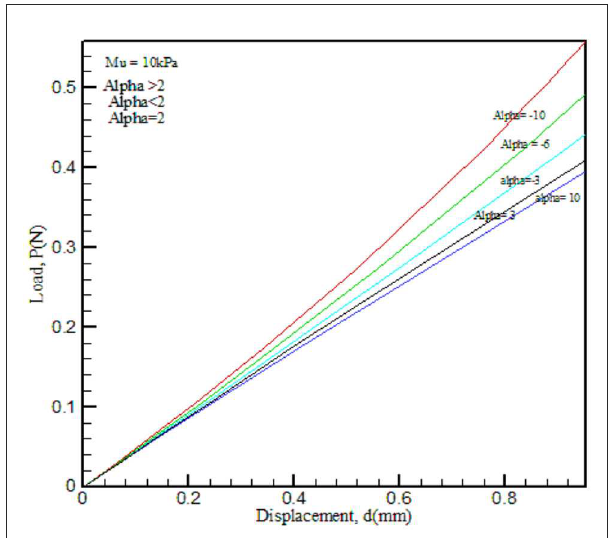
FIGURE6 FE-simulated load–displacement graph for the Ogden hyperelastic model. Material property α was kept constant and µ was varied.